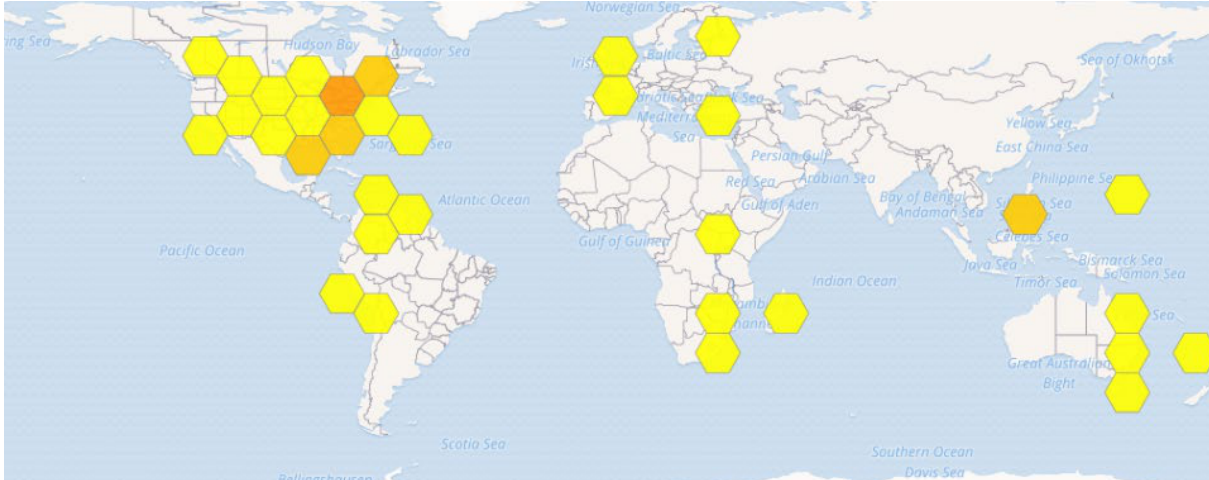
Fig. 1. Trichuris ovis worldwide geolocation record data on request on the platform of the GBIF information system ( Trichuris ovis Abildgaard, 1795 in GBIF Secretariat, 2022)